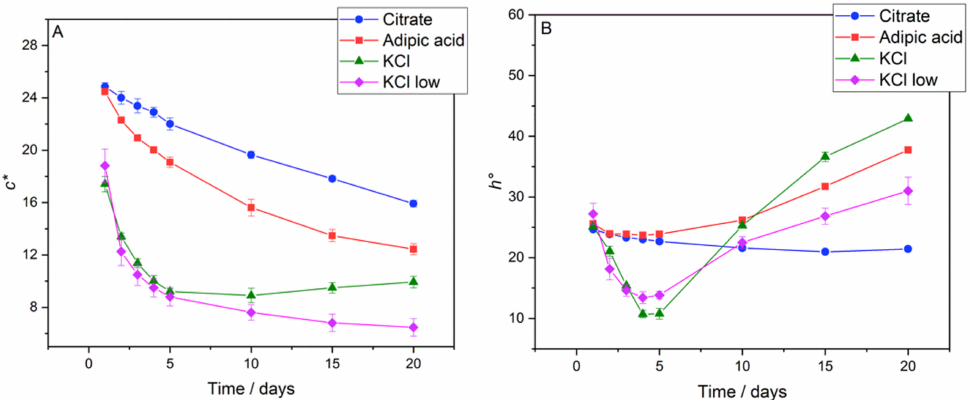
Figure 4. Chroma ( c*, Panel ( A )) and hue angle ( h ◦ , Panel ( B )) for W 1 /O/W 2 emulsions, calculated from the data in Figure 3. The 0.1 M citrate buffer system is represented by circles, 0.1167 M adipic acid by squares, 0.35 M KCl by triangles, and 0.0075 M KCl by diamonds. The h ◦ vs. storage time plots (Figure 4B) for the W 1 /O/W 2 emulsions showed rela- tively stable colour hue for the 0.1 M citrate buffer system, experiencing a decrease from 24.69 ± 0.37 ◦ to 21.43 ± 0.17 ◦ (a change of 13.21%). As expected, h ◦ values for the 0.1167 M adipic acid system and both KCl systems increased over the 20-day period due to increasing b* values (Figure 3B). The increase in h ◦ for the 0.1167 M adipic acid system was from 25.57 ± 0.36 ◦ to 37.74 ± 0.44 ◦ (a change of 47.57%). The effect of ionic strength on